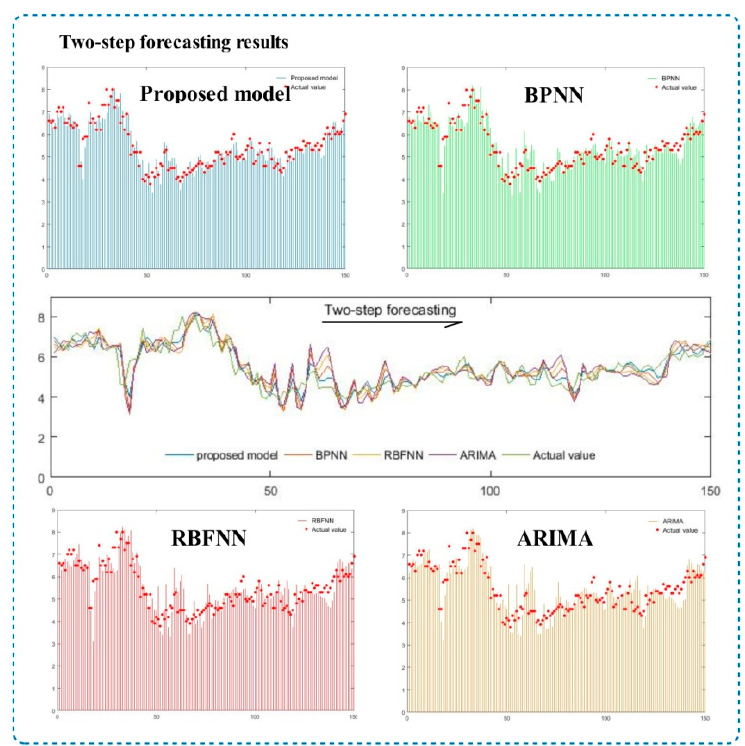
Figure 6. Two-step forecasting results of the proposed model and other traditional models (BP RBF ARIMA).